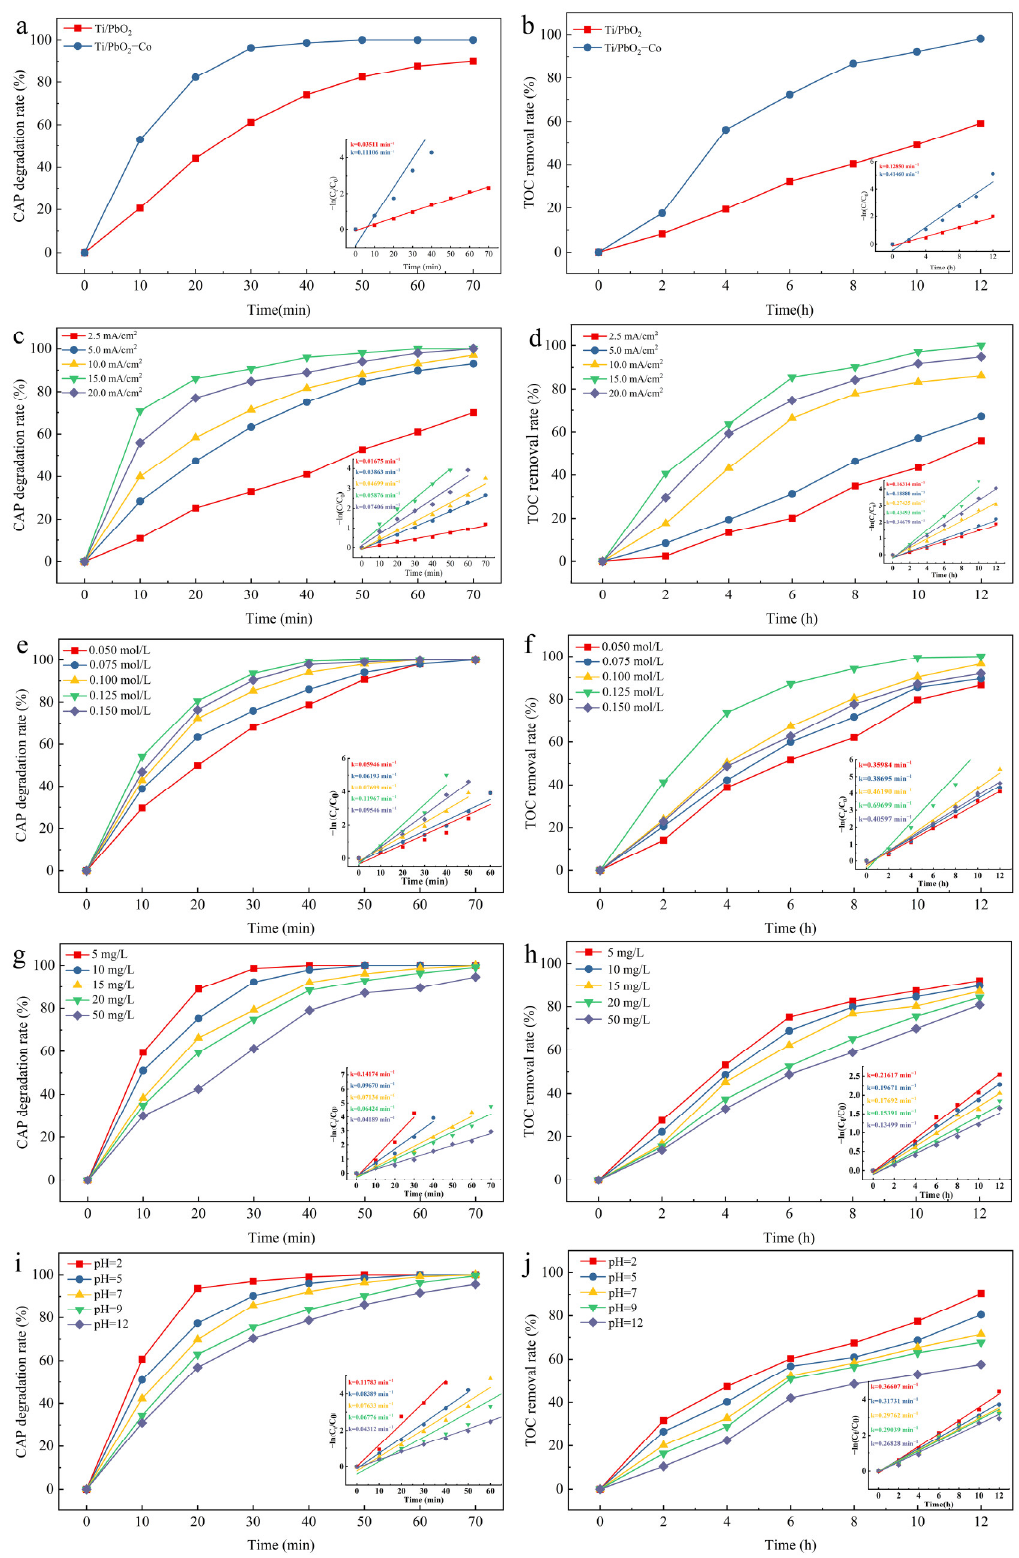
Figure 6. ( a , b ) Effect of Co elemental doping; ( c , d ) current density; ( e , f ) electrolyte concentration; ( g , h ) CAP concentration; and ( i , j ) solution pH on the CAP degradation and TOC removal rates.